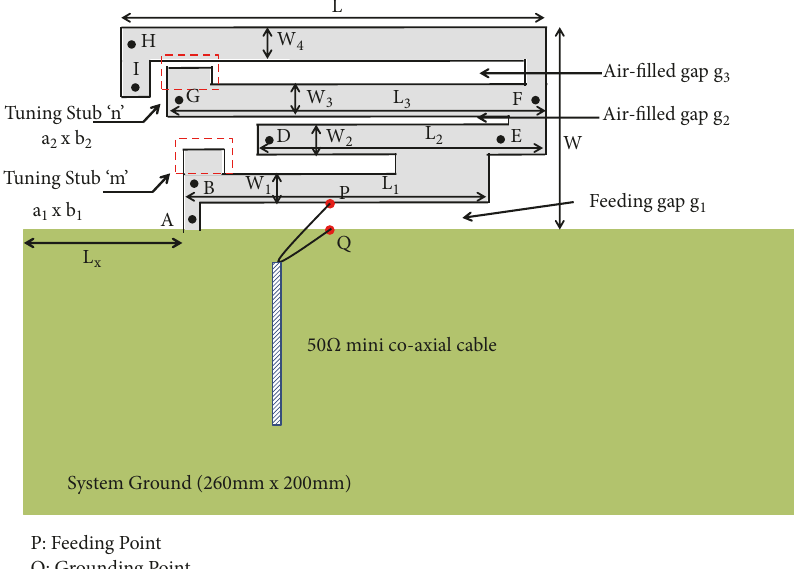
Figure 2: Complete structure of the proposed